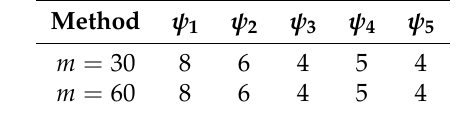
Table 8. The number of iterations for solving Chandrasekhar Integral